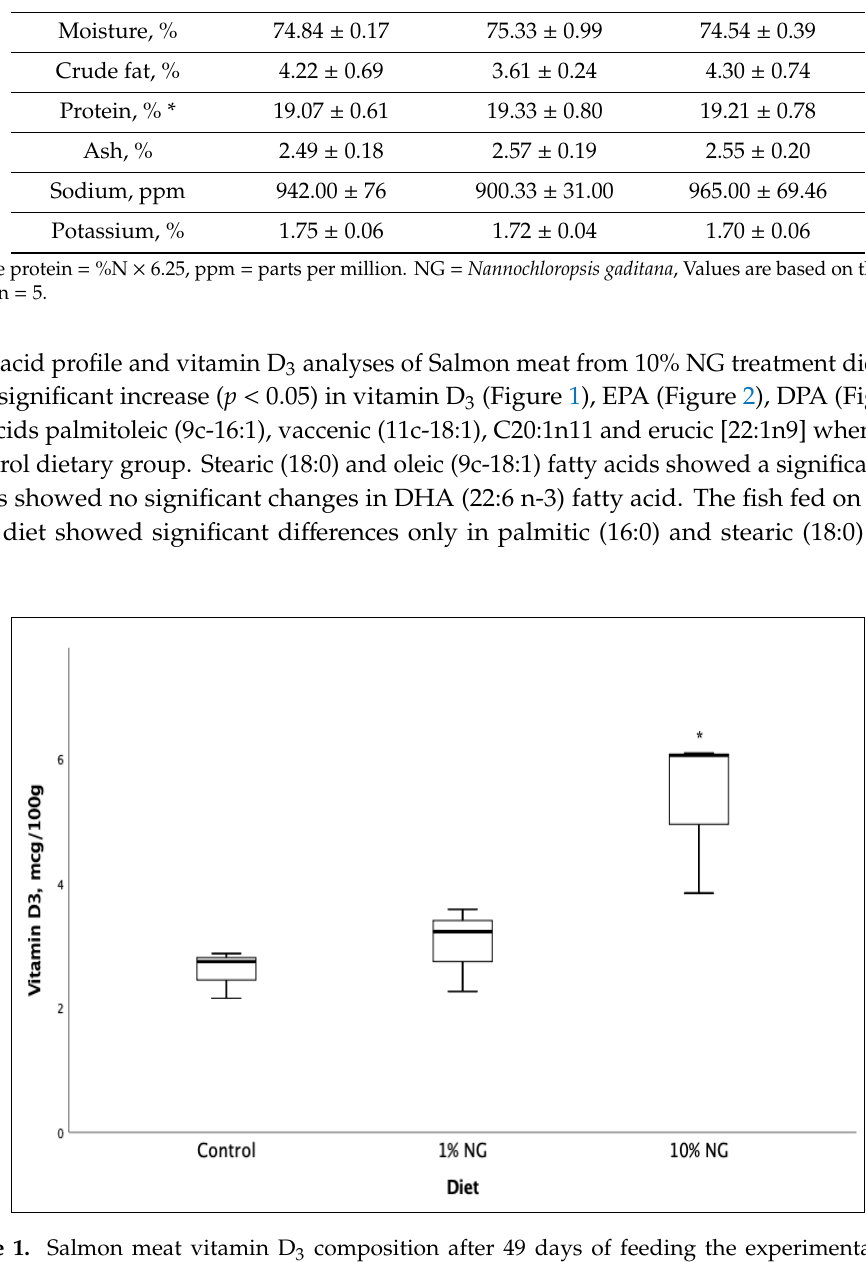
Figure 2. Salmon meat eicosapentaenoic (EPA, 20:5 n-3) fatty acid composition after 49 days of feeding the experimental diets.NG = Nannochloropsis gaditana, * Significantly different from control ( p < 0.05) . Values are based on the mean ± S.D. n = 3.